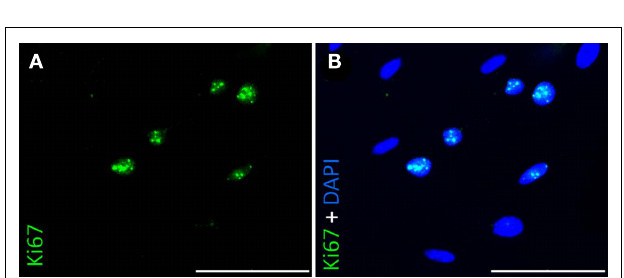
FIGURE 5 | Effects of shear stress examined by an abrasion experiment. Strong abrasion of the confluent cell layer due to the exerted pulling forces is visible (A) .This was prevented by applying the protecting fibrin cover (B) .The black dots in the right picture indicate air bubbles in the fibrin gel above the cells. Scale bars represent 100 μ m (Axio Observer.Z1, Carl Zeiss GmbH, Oberkochen, Germany).